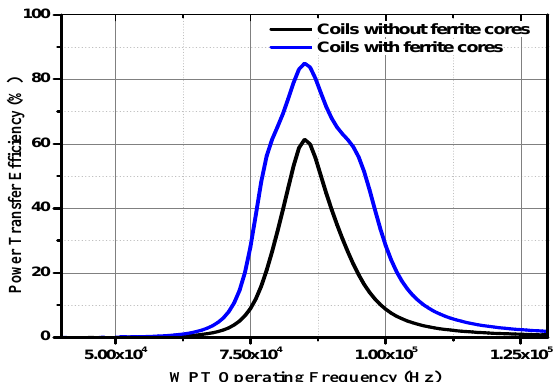
Figure 8. Power transfer efficiency in the absence and the presence of ferrite cores after readjusting the capacitors.